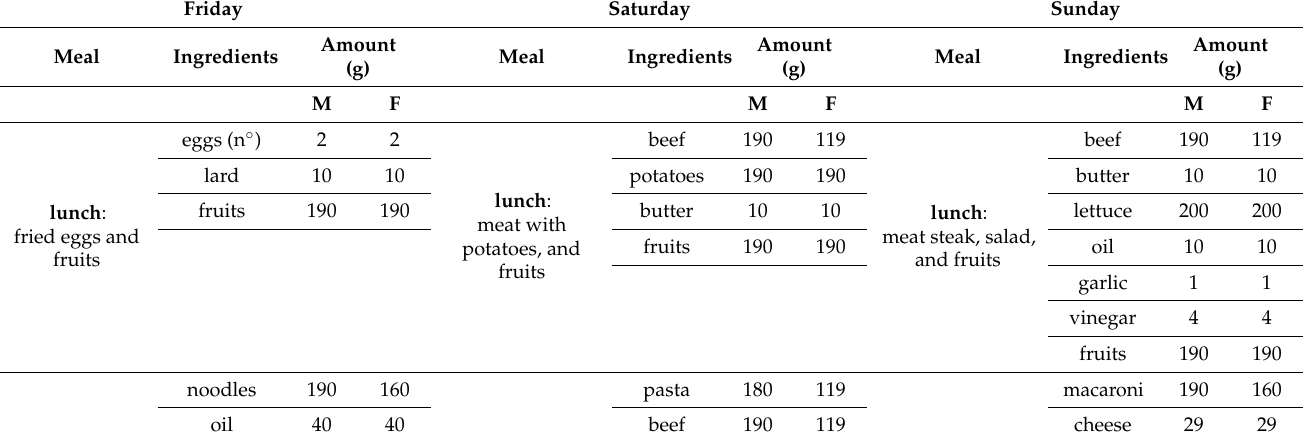
Table 6. Individual meals for 1st and 2nd class patients at lunch and dinner. Months: March, April and May (2)